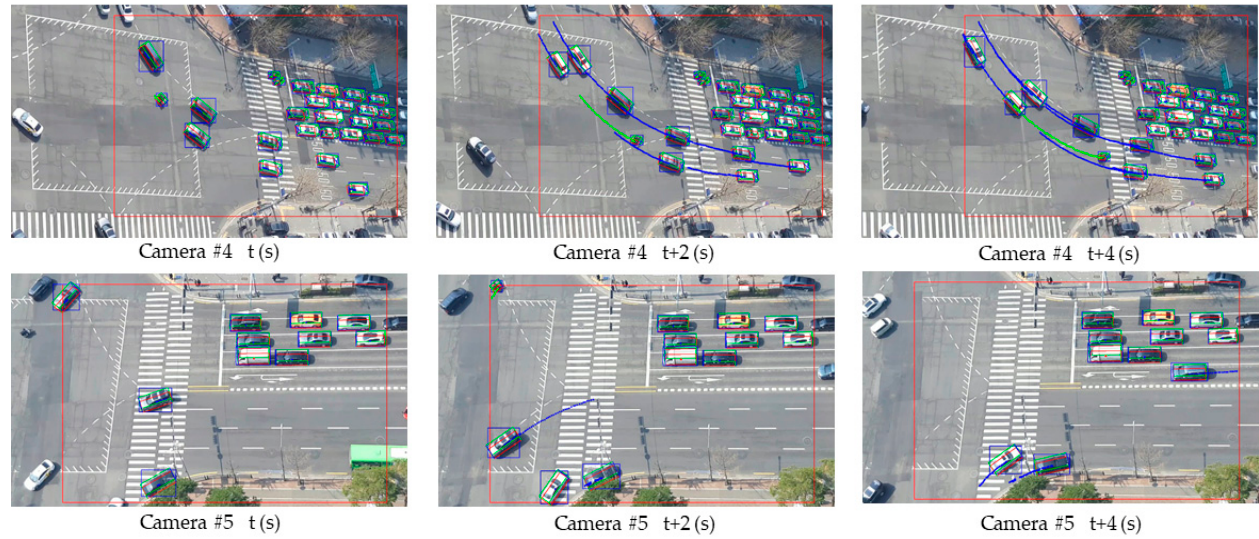
Figure 12. Examples of 2D–3D detection and tracking through models trained in this paper for five cameras (only detected when entering red boxes).